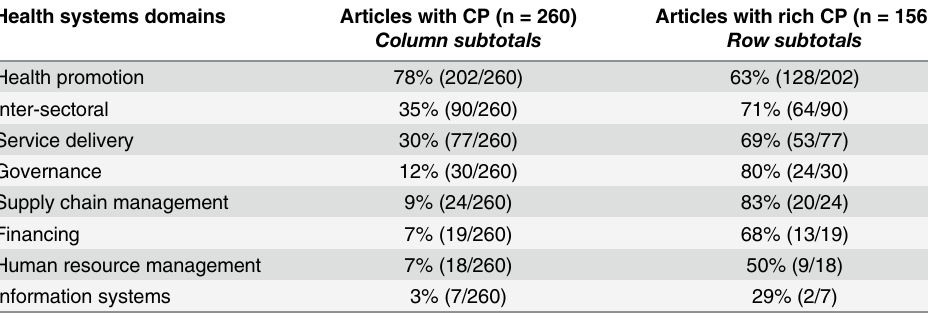
Table 7. Extent of community participation (CP) across health systems